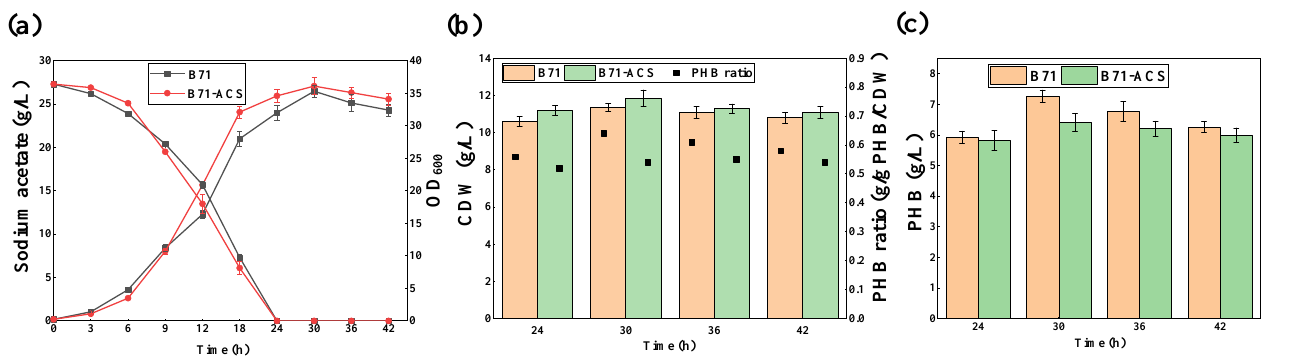
Figure 4. Comparison of growth, acetate utilization, and PHB production of B71 and B71-ACS . B71 and B71-ACS were grown in 60 MMA minimal medium containing 27.3 g/L sodium acetate. ( a ) Acetate concentration and OD 600 . ( b ) CDW and PHB ratio. ( c ) PHB production. Error bars represent standard deviation (SD), n = 3.